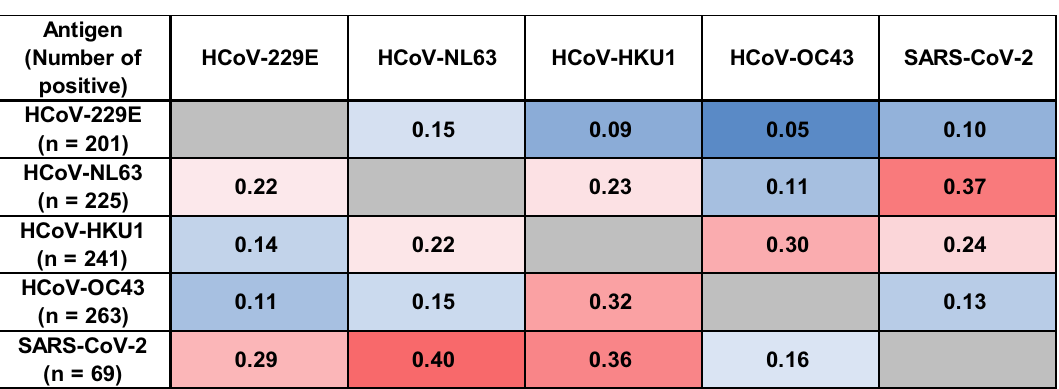
Figure 3. Correlation analysis of the cut-off-value ratio to the four HCoVs and to SARS-CoV-2 in children who were collected before the COVID-19 pandemic (2015–2018). Positive correlations are symbolized by graded shades of red, and negative correlations are by graded shades of blue. The coefficient of determination (R 2 ) for each pair of viruses are